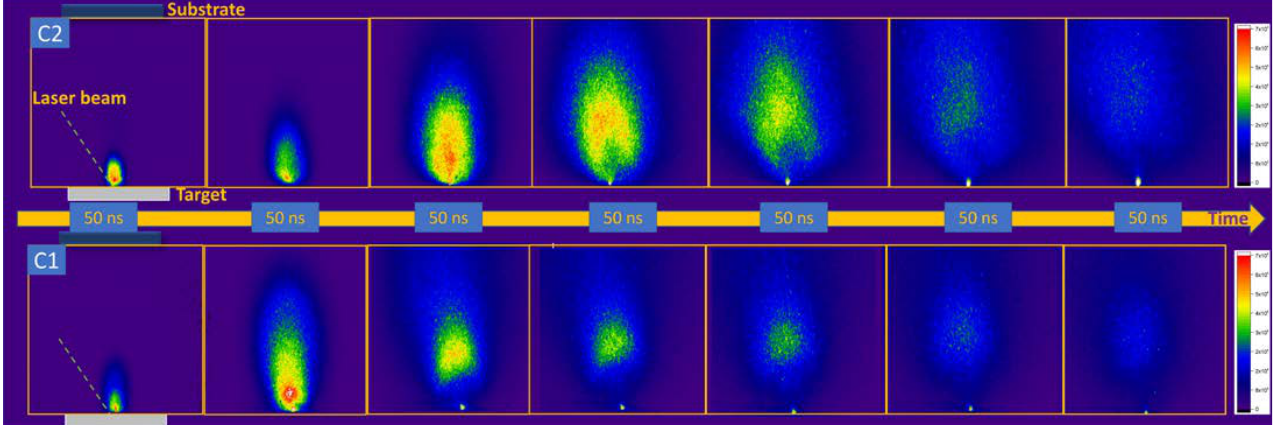
Figure 1. ICCD images of the laser-produced plasmas on C1 (Al 2 O 3 + SiO 2 ) and C2 (Al 2 O 3 + TiO 2 + WC) on a 1.5 µs time span.